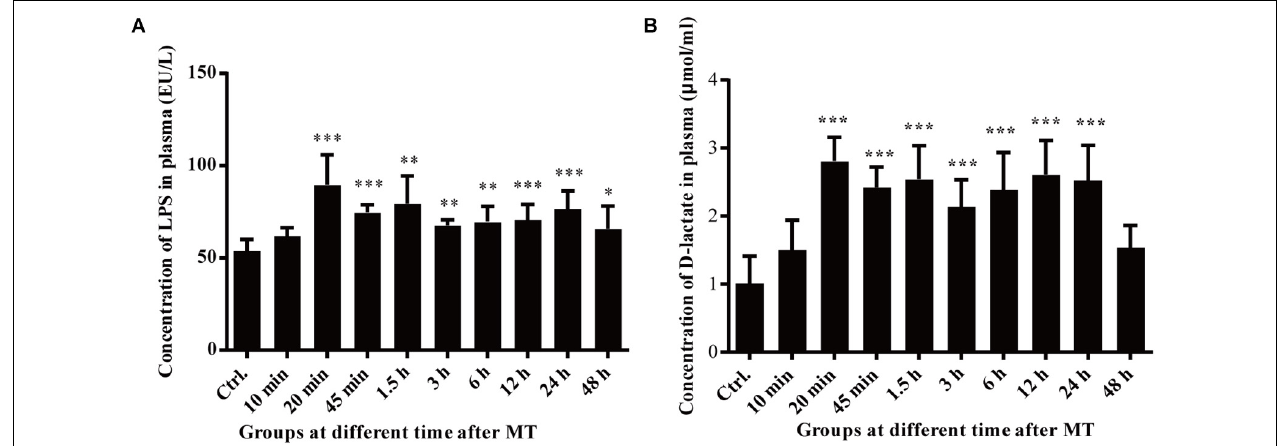
FIGURE 8 | Changes in the plasma LPS and D-lactate concentrations of the SD rats at different time points after MT. (A) Changes in the plasma LPS concentration of the SD rats at different time points after MT (EU/L). There were statistically significant differences at 20, 45 min, 1.5, 3, 6, 24, and 48 h after MT (* P < 0.05, ** P < 0.01 and *** P < 0.001 vs. the control). (B) Changes in the plasma of D-lactate concentration of the SD rats at different time points after MT ( µ mol/ml). There were statistically significant differences at 20, 45 min, 1.5, 3, 6, 12, and 24 h, after MT (* P < 0.05, ** P < 0.01 and *** P < 0.001 vs. the